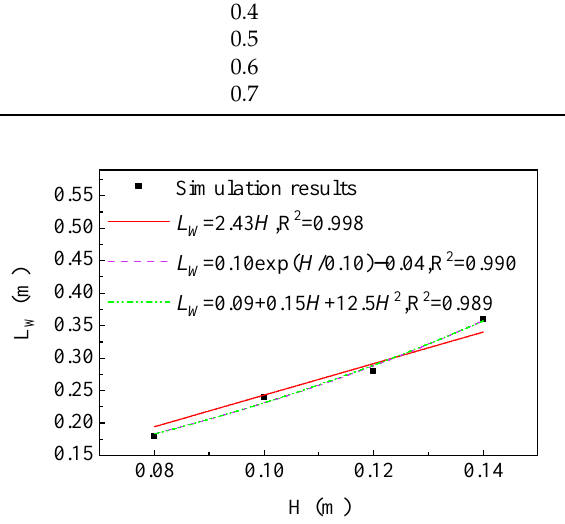
Table 3. Length of SHGs bend zone with different height–width ratios. Height–Width Ratio